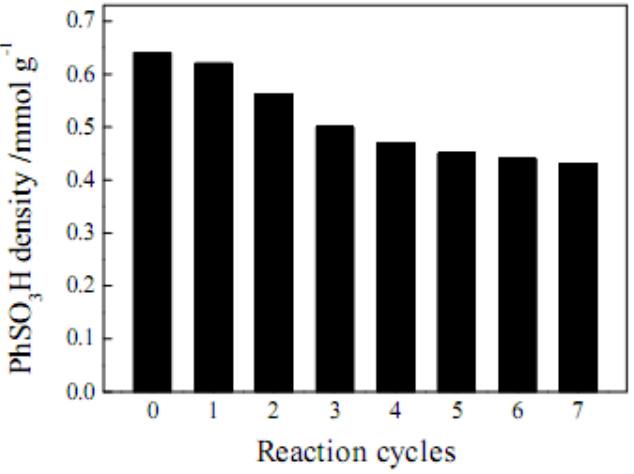
Figure 6. Variation of the SO H density on the carbon catalysts in a series of 2-h acetic 3 acid esterification reaction